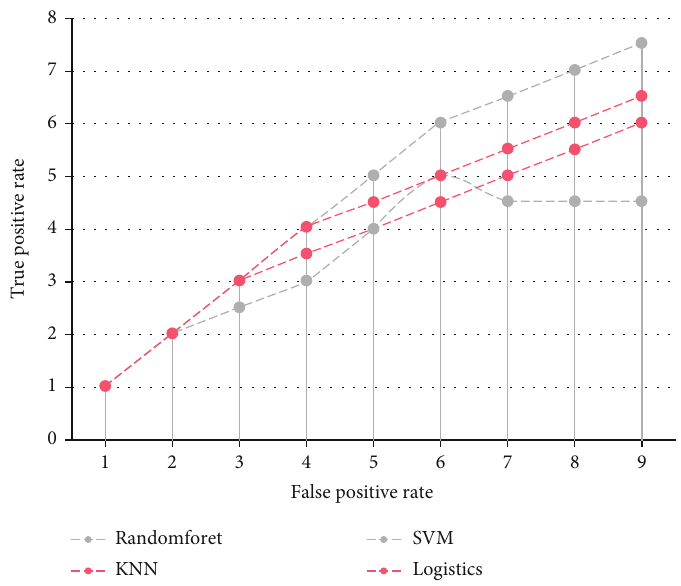
Figure 4: Comparison of Curve